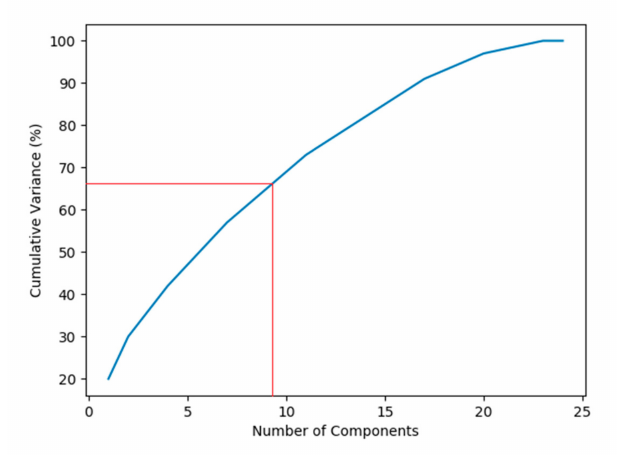
Figure 4. Cumulative variance plot. Table 2. A highly correlated original feature for each principal component. Principle Component